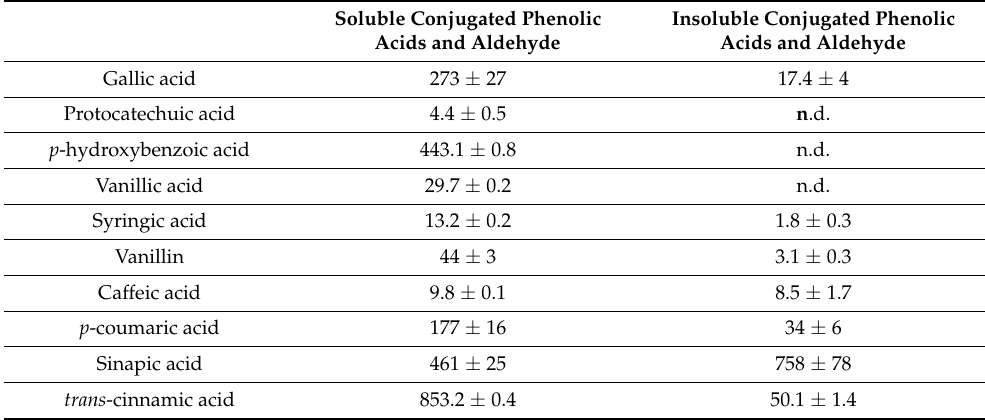
Table 2. Soluble conjugated and insoluble bound phenolic acids and aldehyde ( µ g g − 1 ) in Camelina sativa defatted seed meal (DSM). Average values ± standard deviation ( n = 3) are